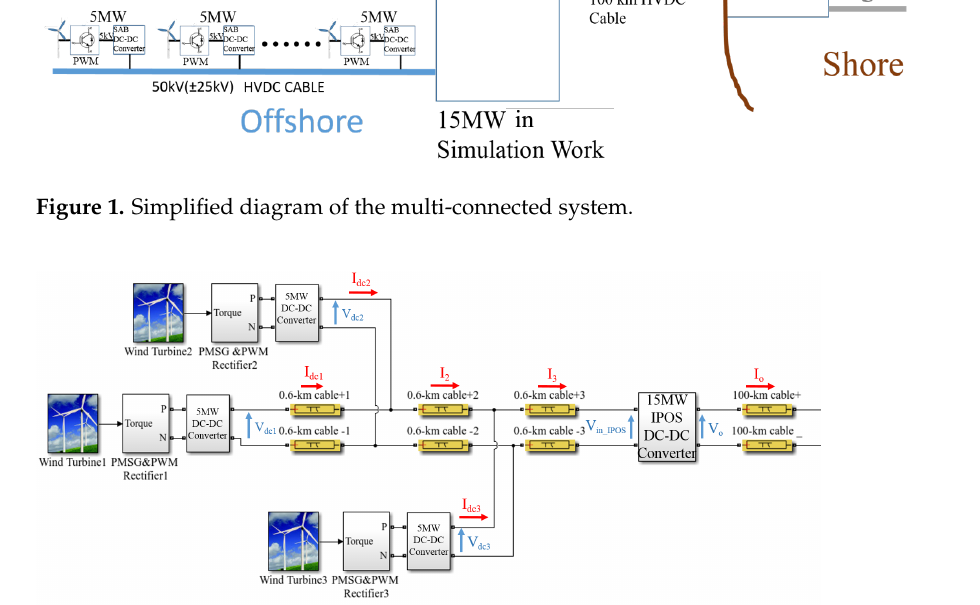
Figure 2. Sending end circuit diagram of a 15 MW wind farm based multi-terminal DC system.